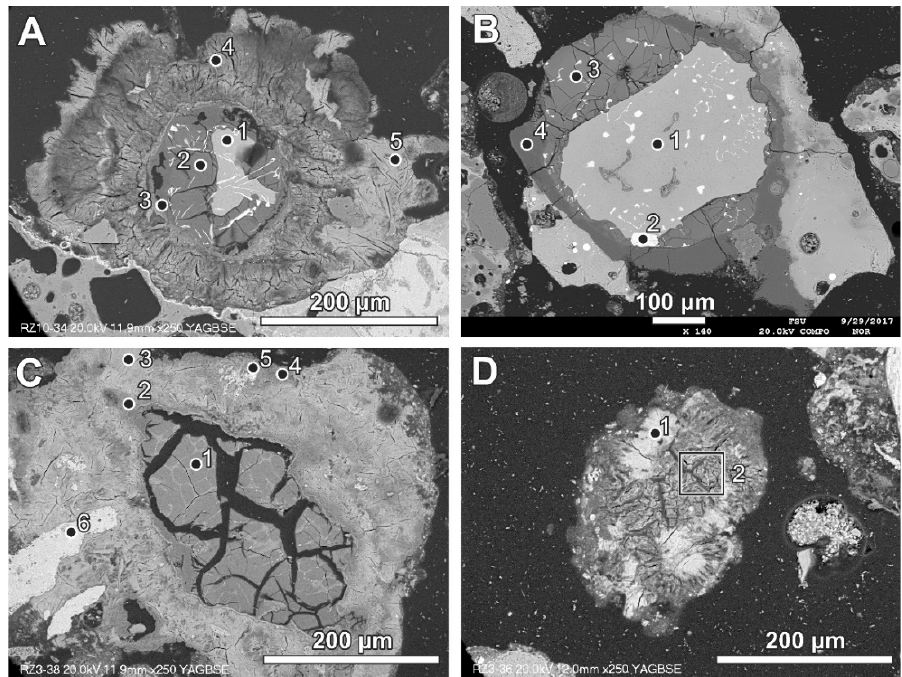
Figure 5. ( A ) Reaction rims around metallic Al (also see Figure 8)—numbers of spots correspond to the analyses presented in Table 3 (SEM BSE image, sample RZ10); ( B ) relatively simple reaction rim around a slightly oxidised Al core—numbers of spots correspond to the analyses presented in Table 3 (SEM BSE image, sample RZ11); ( C , D ) advanced stages of Al components’ transformation—numbers of spots and areas correspond to the analyses presented in Table 3 (SEM BSE images, sample